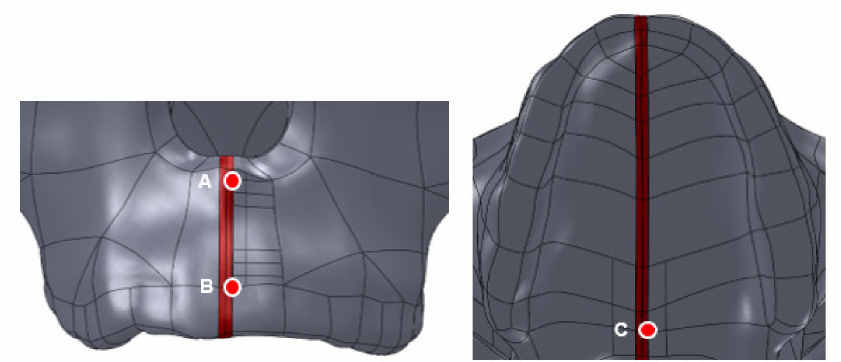
Figure 1. The 3D skull FEA model with midpalatal suture. Point A, the most anterior point of nasal floor; point B, the most anterior inferior point on the maxillary alveolar process; point C, the most posterior point at the posterior margin of the hard